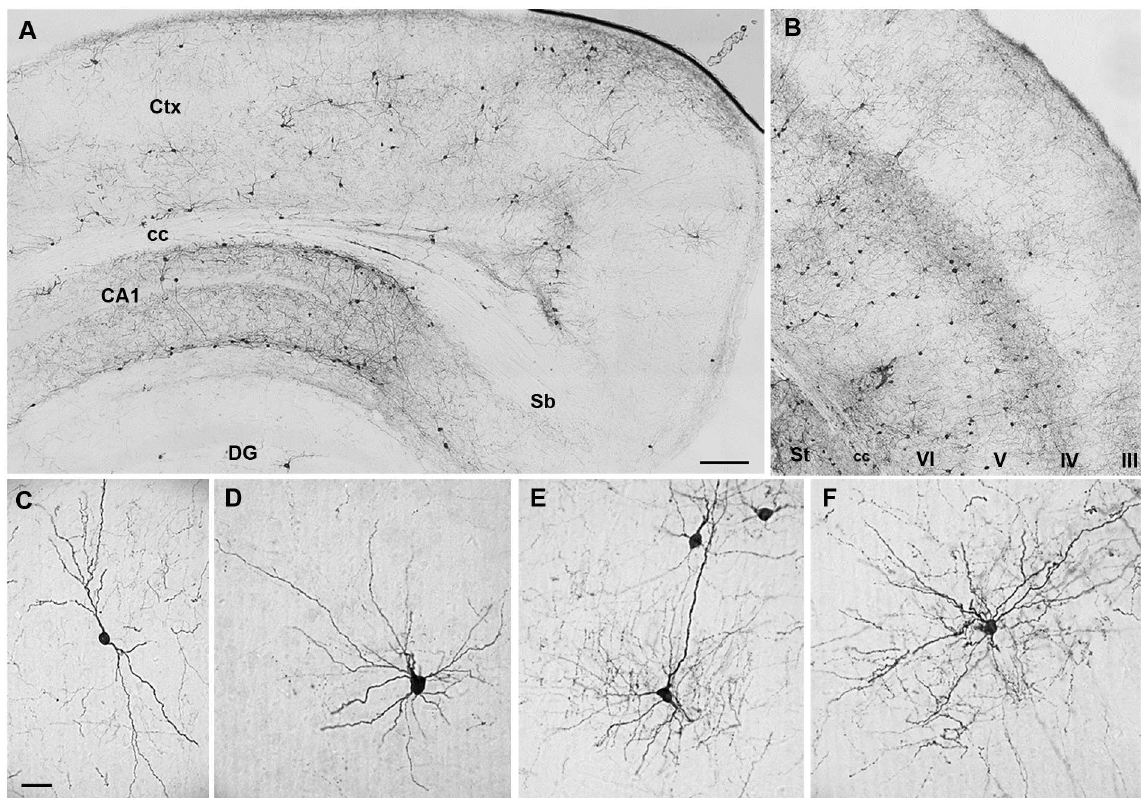
Fig 5. Distribution and differentiation of in toto cryopreserved MGE-derived precursorsafter transplantation. (A) Detection of grafted cells by immunohistochemistry against GFP in the neocortex (Ctx) and hippocampus four weeks after the transplant. (B) Note the wide distributionof cryopreserved grafted cells in multiplecortical layers and the dark background due to dendrite concentration in layer IV. (C-F) MGE-derived cells in the cortex differentiatedinto neuronspresentingtypical morphology of interneuron subtypese.g., bitufted (C), multipolar (D), chandeliercells with synapticboutons resembling candlesticks (E), or basket cells (F). In hippocampus, grafted cells accumulatedin CA1 and dentate gyrus (DG). Corpus callosum(cc); cortical layers (III-VI); striatum (St); subiculum(Sb). Scale bars for A and B: 200 μ m; in C for D-F: 25 μ m.